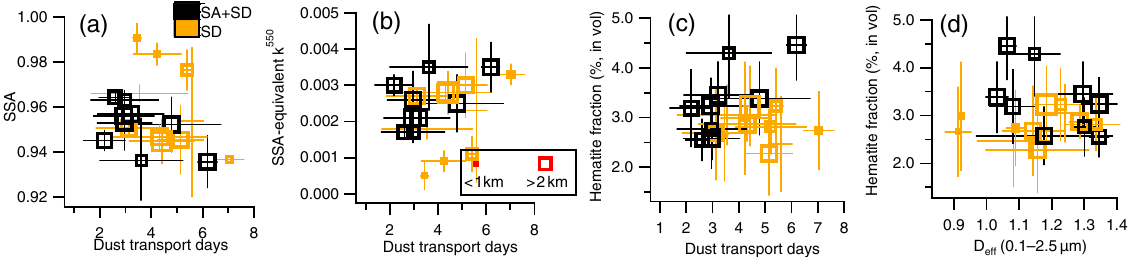
Figure 17. The aircraft-measured aerosol optical properties: (a) SSA; (b) the imaginary part of refractive index at 550nm ( k 550 ); (c) hematite volume fraction as a function of potential dust age; (d) hematite volume fraction vs. D eff ,( 0 . 1–2 . 5 ) The smaller and larger markers indicate the results in the MBL and SAL,